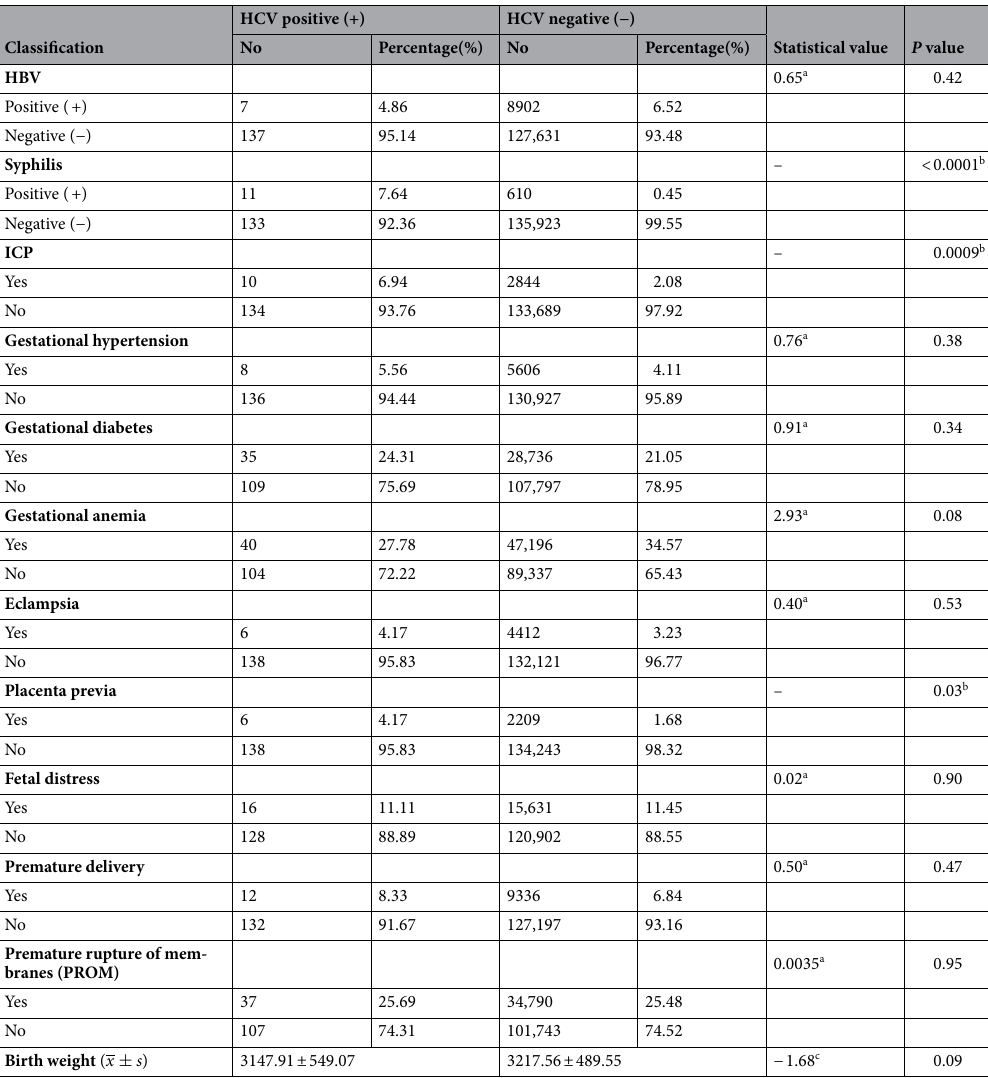
Table 2. Univariate analyses of HCV associated factors among pregnant women in three provinces. a χ 2 value. b Fisher test. c t-test value.